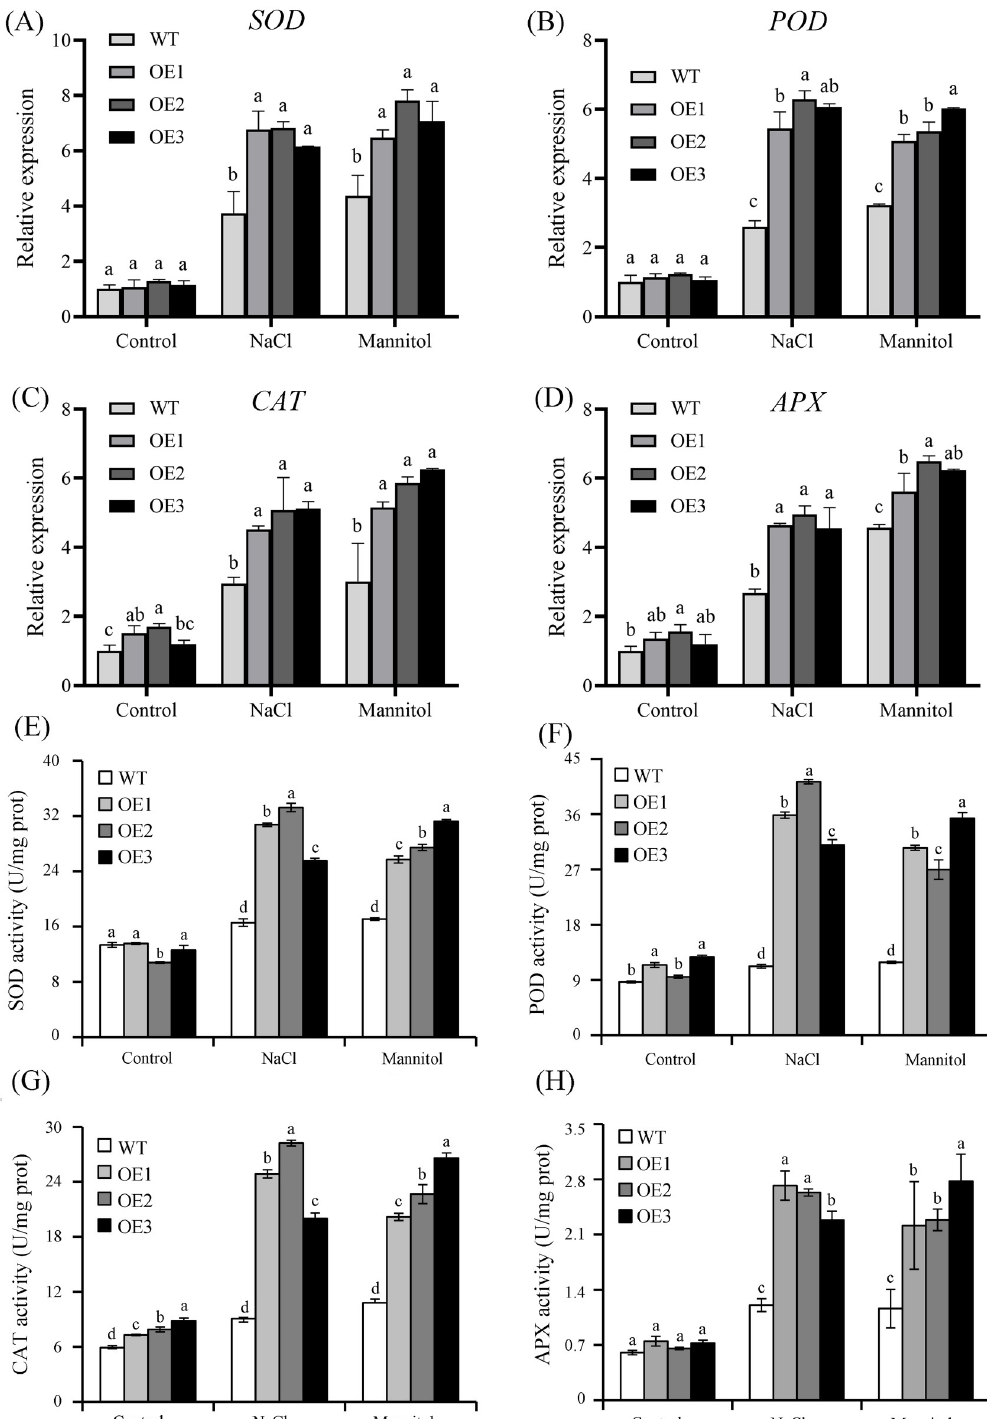
Fig 9. The expression of ROS scavenging-related genes and the enzyme activities in WT and transgenic plants under salt and osmotic stresses. (A-D) The expression of ROS scavenging-related genes (SOD, POD, CAT, APX) in WT and transgenic lines, (E, F) The activities of SOD, POD, CAT and APX enzyme in WT and transgenic lines. The data are presented as the mean ± SE of three independent experiments. Different letters above the columns indicate significant differences (P < 0.05) according to Duncan’s multiple range